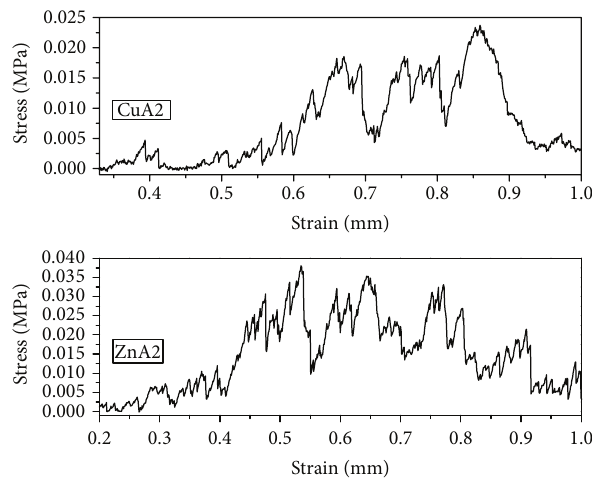
Figure4:Indicativestress(MPa)-strain(mm)curvesforeachgroup of glass-ceramic scaffolds. The compressive load was applied until 1mm (12.5%) compressive strain was achieved along the 8 mm dimension (height).